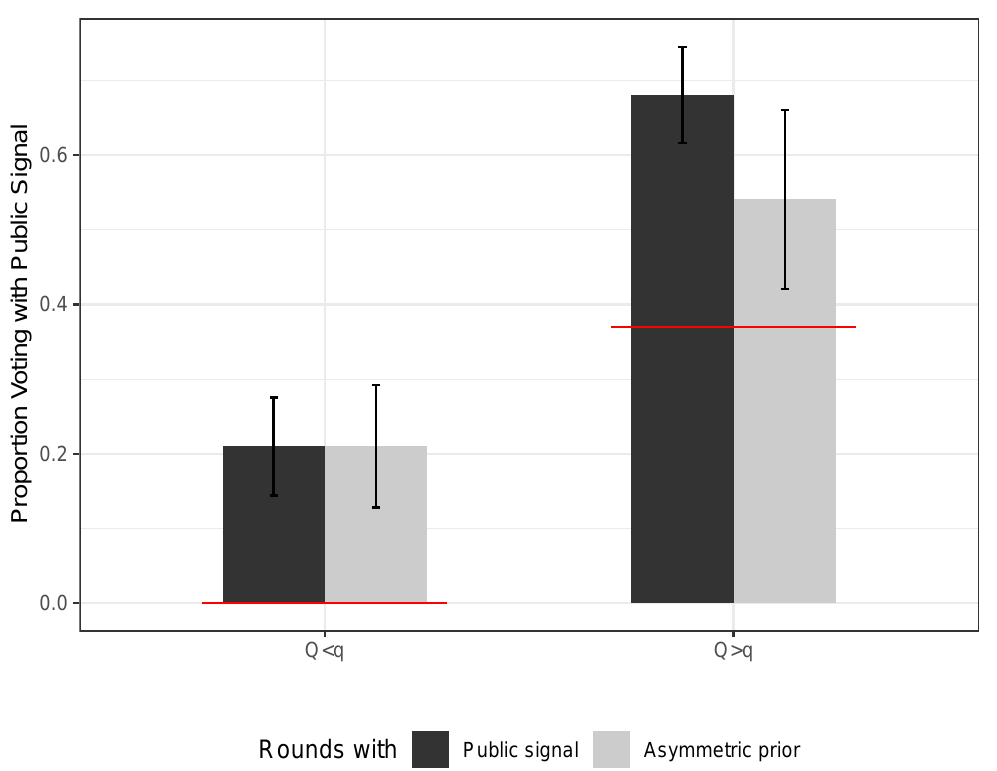
Figure 3. Asymmetric prior treatment : Average fraction of votes with public signal under mismatch, and 95% confidence intervals. Standard errors are clustered at the individual level. Dark columns correspond to rounds where the public signal was provided. Light columns correspond to the last 10 rounds in each sessions, where the public signal content was conflated into the prior. Note: Horizontal lines represent the symmetric responsive equilibrium prediction for µ